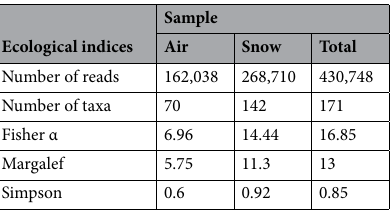
Table 2. Sample data and ecological indices of the fungal DNA recovered from air and snow samples from Livingston Island, South Shetlands, Antarctica.